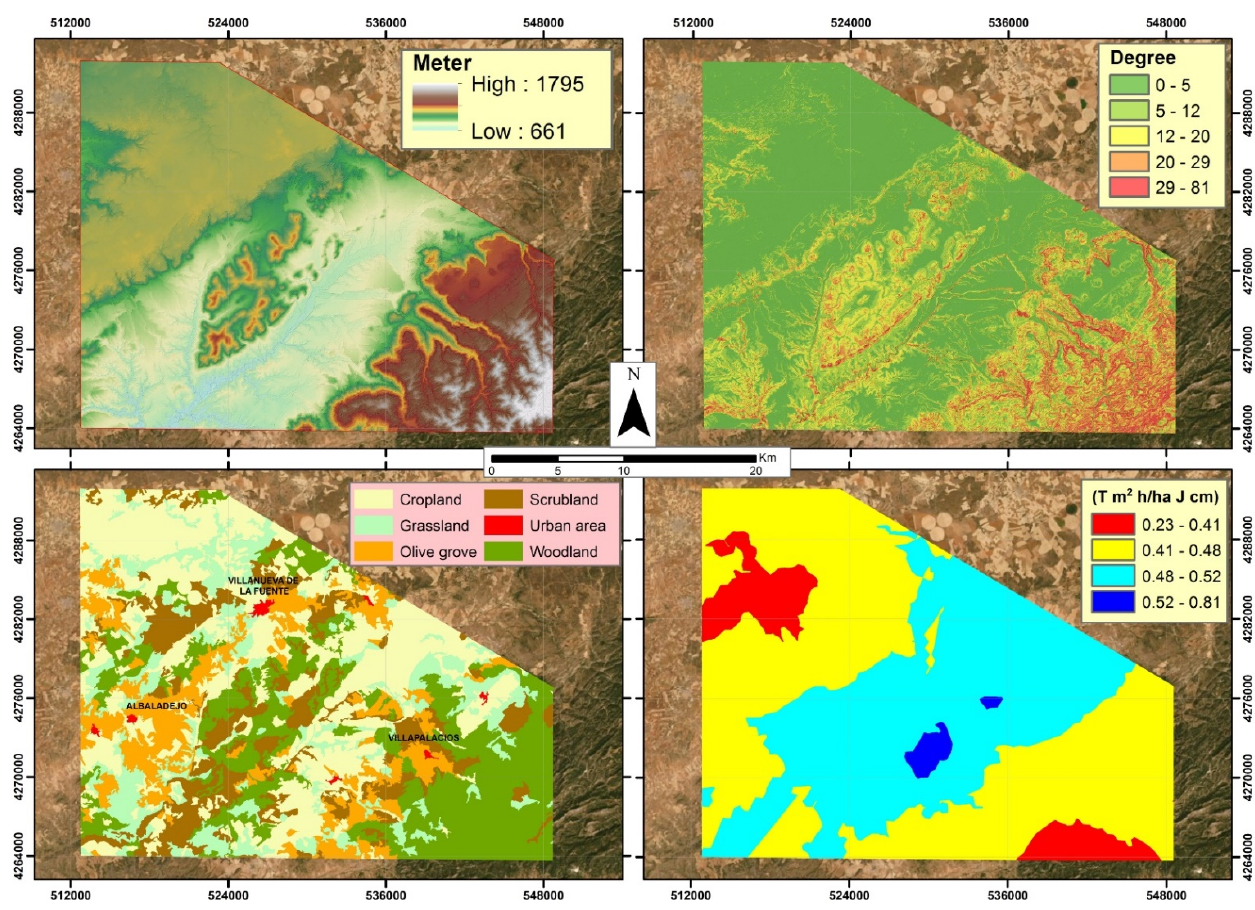
Figure 3. Digital terrain model (LED); slope map (degree); land use map and soil erodibility map (Factor K-T m 2 h/ha J cm).